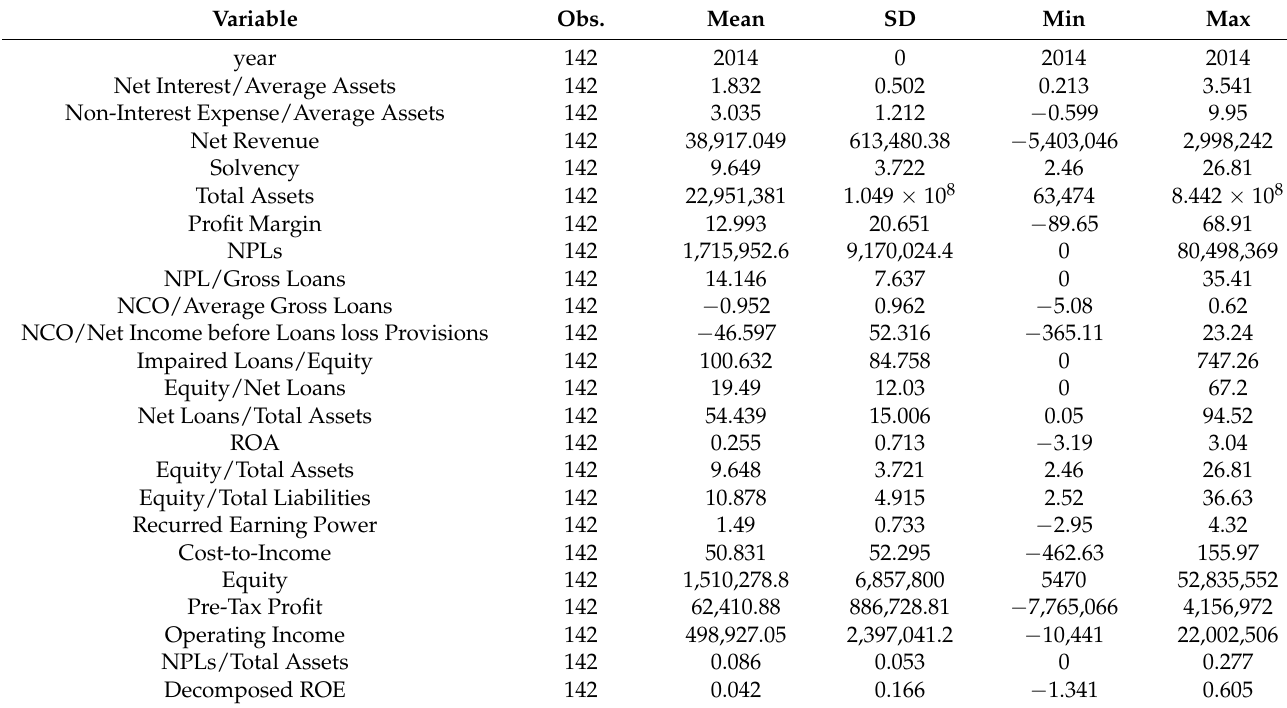
Table A4. Descriptive statistics for the 142 Italian banks for the year